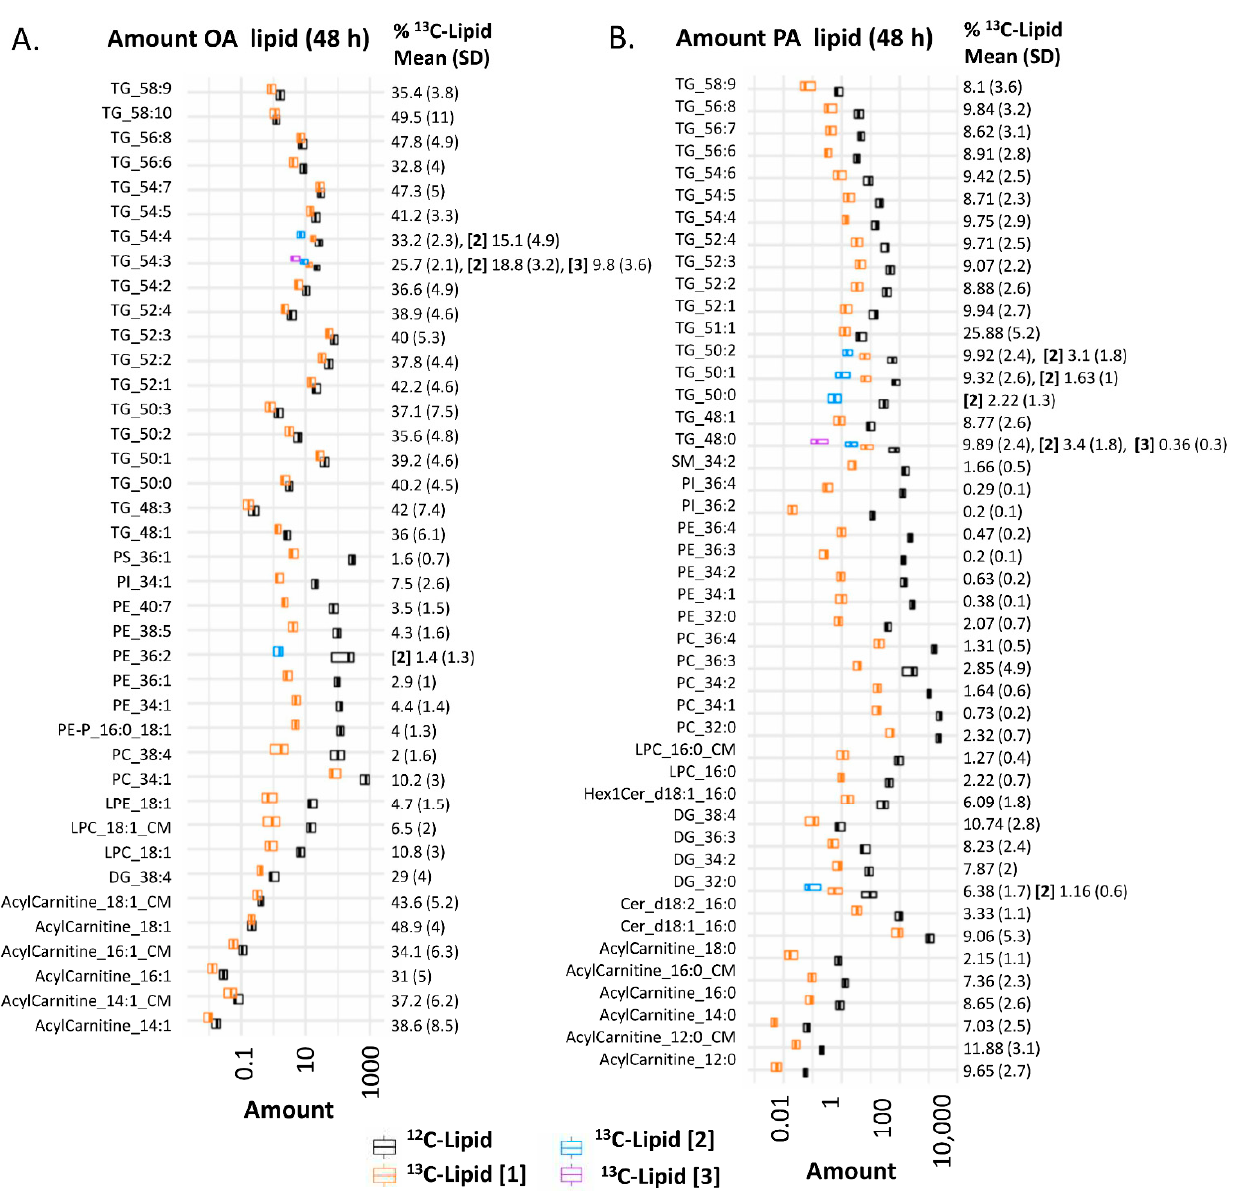
Figure 1. Amount of lipid in placental explants ( n = 22) incubated in 100 µ M 13 C-OA ( A ), or 100 µ M 13 C-PA ( B ) for 48 h. Boxplots (median and interquartile range) show the amount (pmol lipid/mg of dry explant) of 13 C fatty acid-labeled lipids (orange: mono-labeled [1], light blue: di-labeled, purple: tri-labeled [3]) and endogenous 12 C lipids (black) in placental explants and in conditioned media (CM). x-axis is log10 scaled. Numbers to the right show percentage of each lipid labeled with 13 C out of the total of that specific lipid (100*Amount 13 C lipid/total amount of 13 C + 12 C of corresponding lipid) alongside standard deviation (SD). Bold square brackets show percentage of each particular lipid di- [2] or tri- [3] labeled with 13 C-PA or 13 C-OA. Abbreviations; DG: diacylglycerol, Cer: ceramide, Hex: hexose, LPC: lysophosphatidylcholine, LPE: lysophosphatidylethanolamine, OA: oleic acid, PA: palmitic acid, PC: phosphatidylcholine, PE-P: phosphatidylethanolamine-plasmalogen, TG: triacylglycerols.